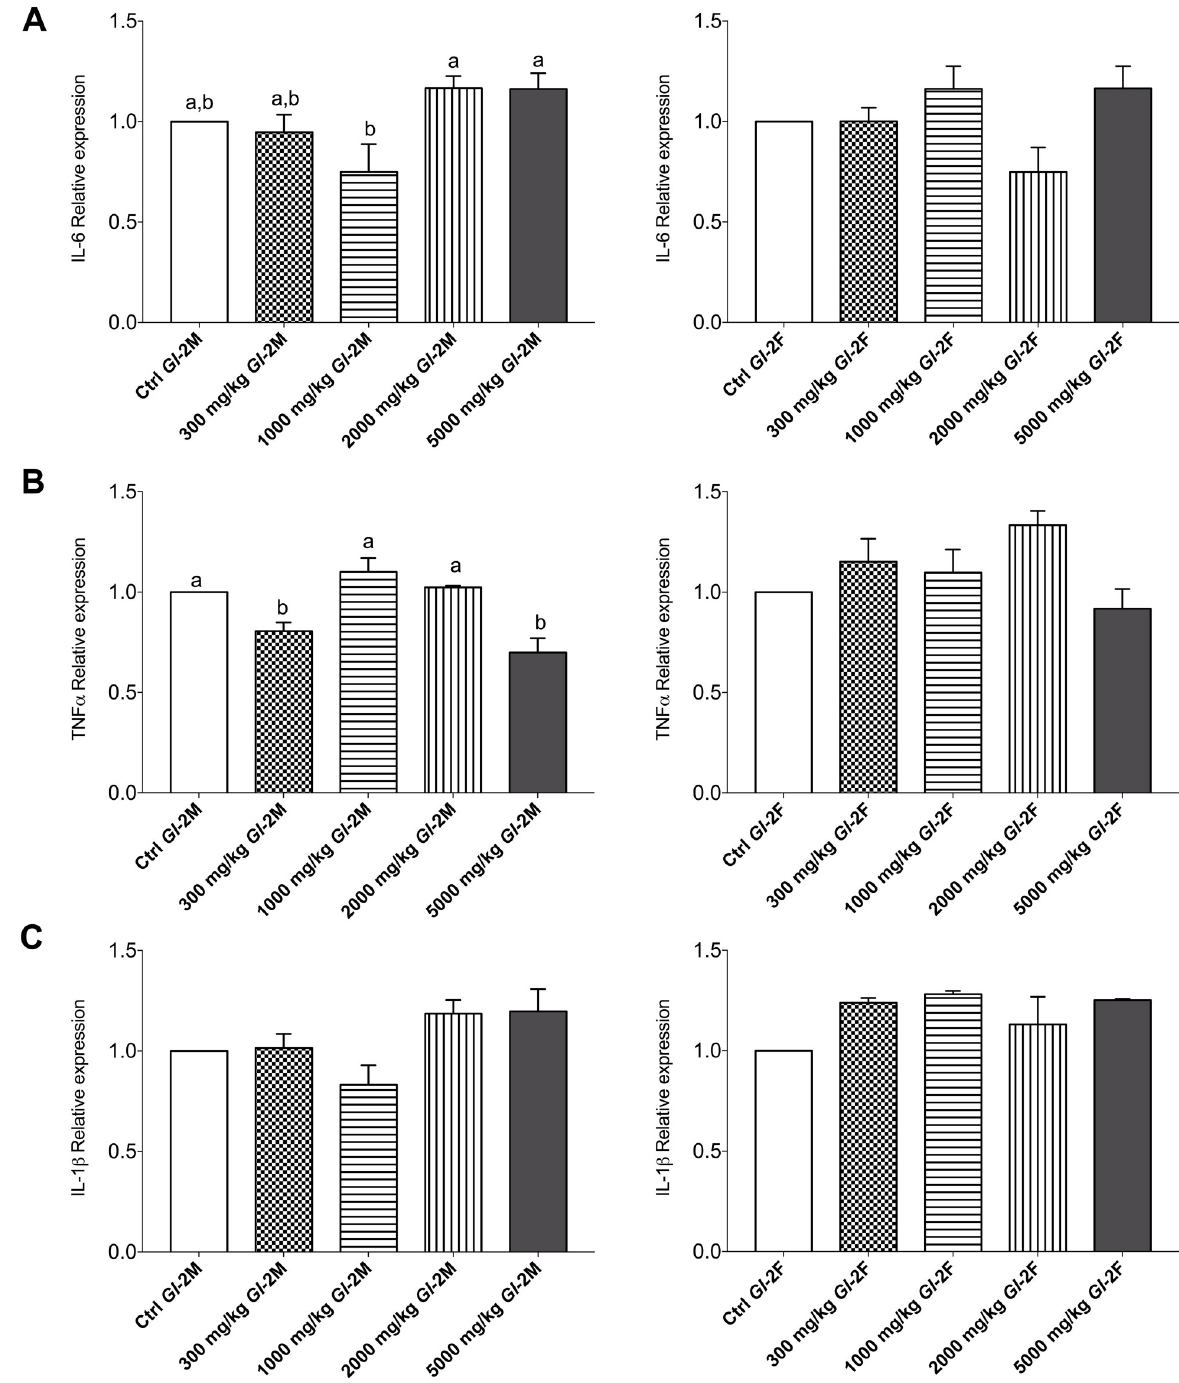
Fig 12. Expression of genes linked to inflammatory responses in liver tissue from the male (M) or female (F) Wistar rats fed with the control diet (Ctrl) and different doses of the standardized Gl -2 extract of Ganoderma lucidum for 14 experimental days. A: IL-6. B: TNF- α . C: IL-1 β . Data are presented as mean ± SEM per experimental group. Different letters on a column indicate significant differences, p < 0.05. Values ( p ) correspond to one-way ANOVA from Tukey’s multiple comparison test. The dose administered per experimental group is described in the materials and methods